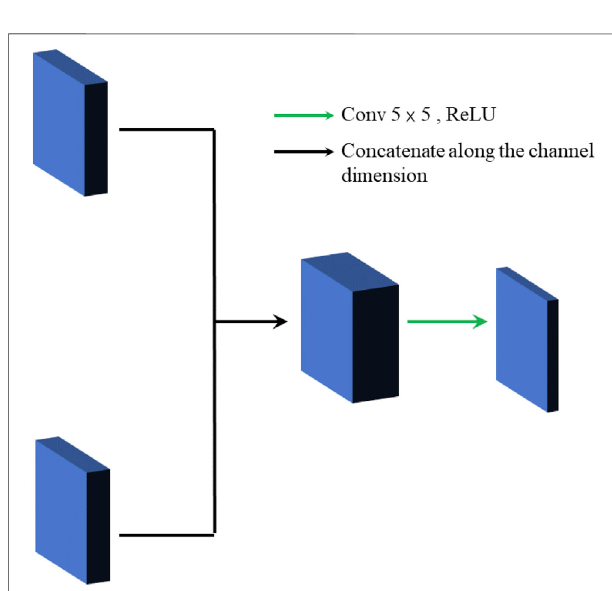
FIGURE 3 | Feature fusion